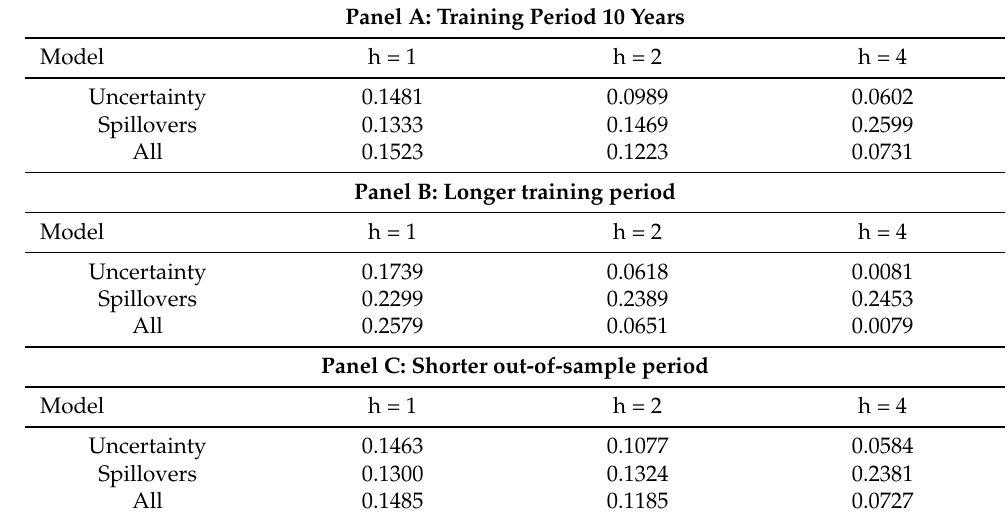
Table 4. Forecasting results for